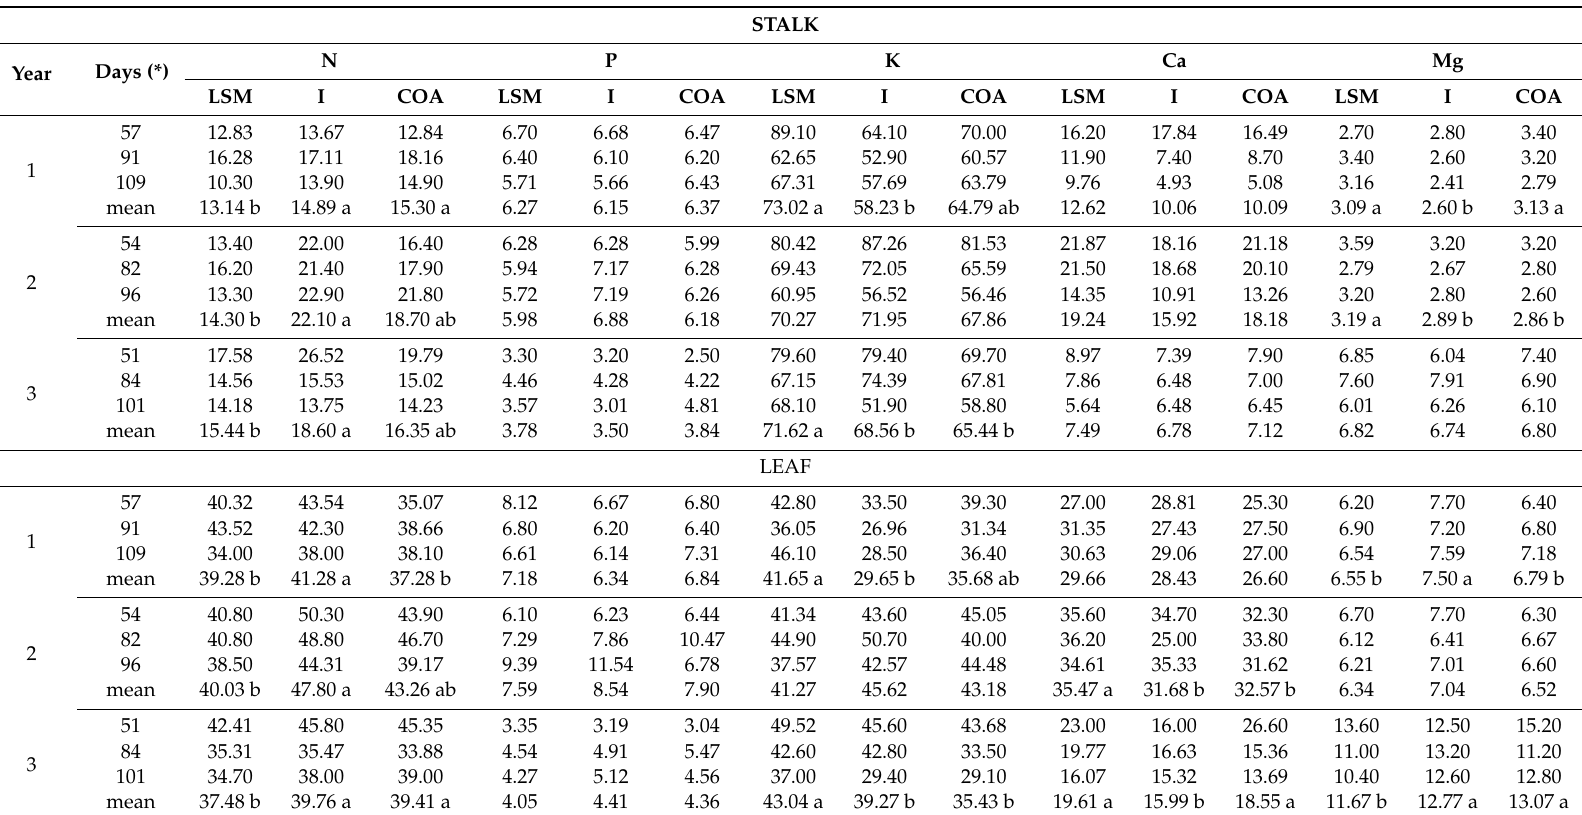
Table 9. Macronutrient contents (g kg − 1 dry matter) in the stalk and leaf of celery, in the inorganic (I) and organic (local sheep manure, LSM; commercial organic amendment, COA) fertilization